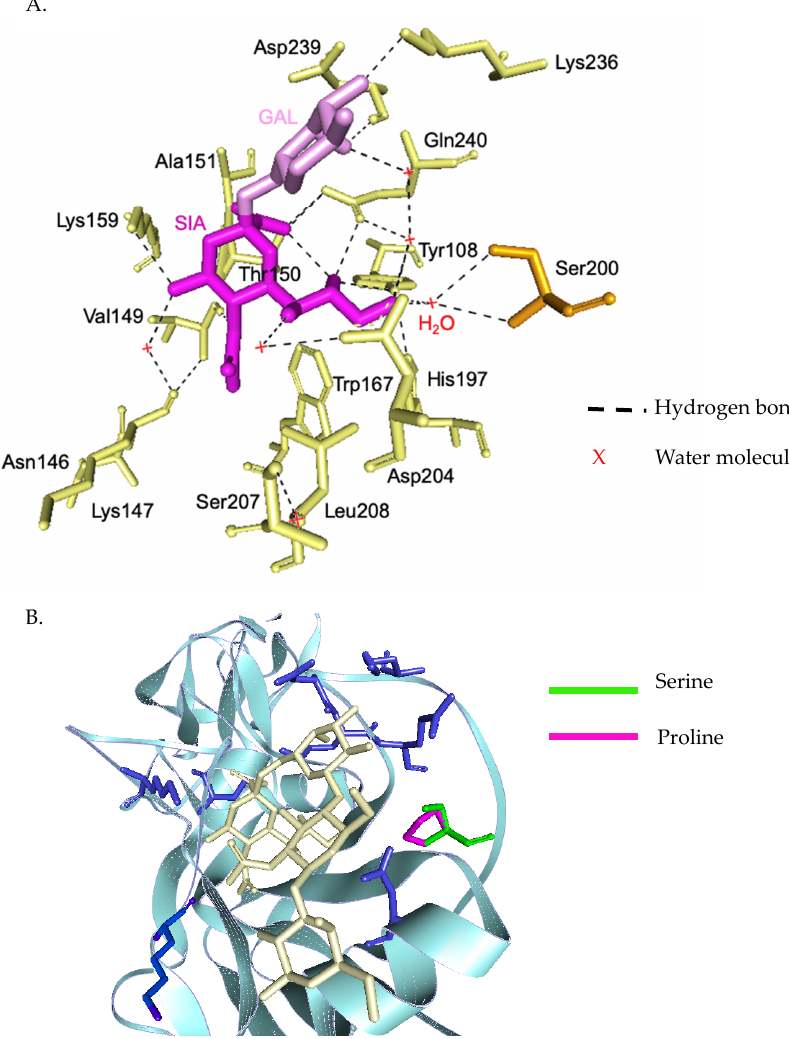
Figure 3. Three-dimensional structural analysis of H1N1 HA receptor binding site and interactions with the sialic acid receptor analogues ( A ). Residues and side-chain interactions of receptor binding site of A/Michigan/45/2015 (H1N1) HA protein and sialic acid. Ser200 and Asp204 together coordinate a water molecule that hydrogen bonds with the 9-hydroxyl group of sialic acid ( B ). Superimposed HA structures of A/Michigan/45/2015 (H1N1) and the mutant Ser200Pro. This results in a loss of coordination with water molecule, disrupting the hydrogen bond with sialic molecule